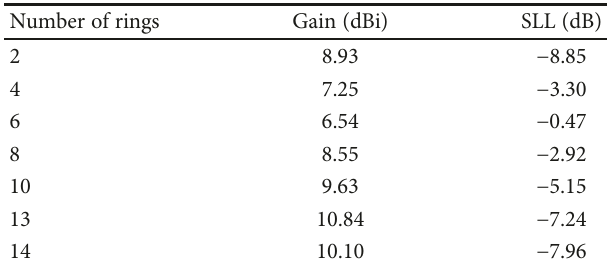
Figure 4: Radiation pattern analysis as a function of the number of rings. Table 1: Analysis of the number of rings of the omnidirectional ring-based